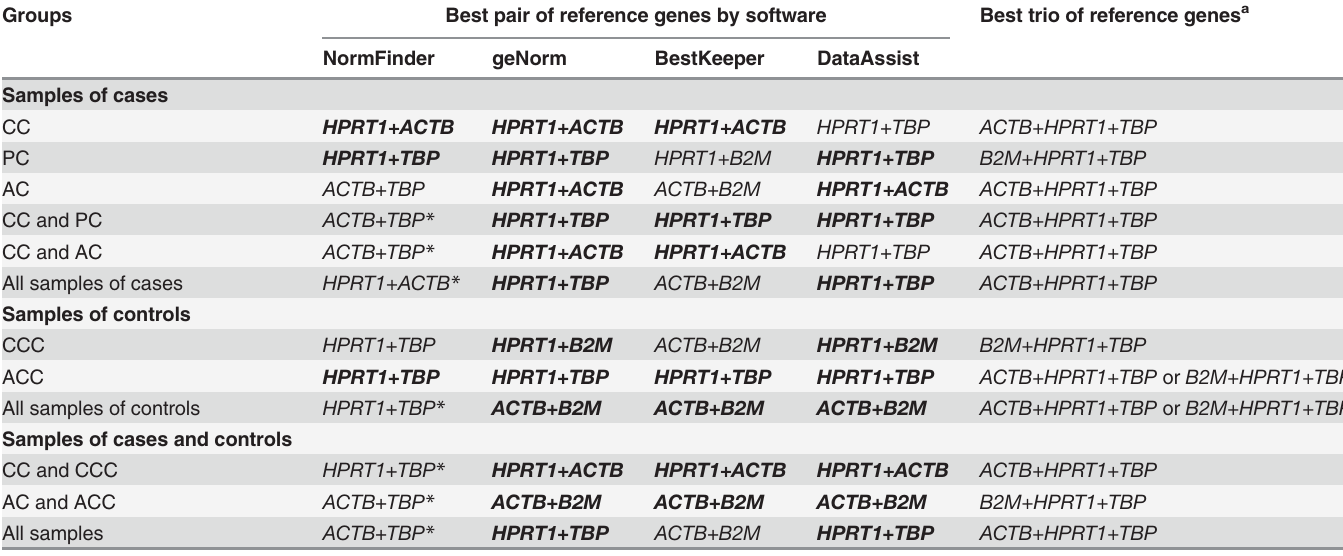
Table 4. Best combination of reference genes for each group of sample.